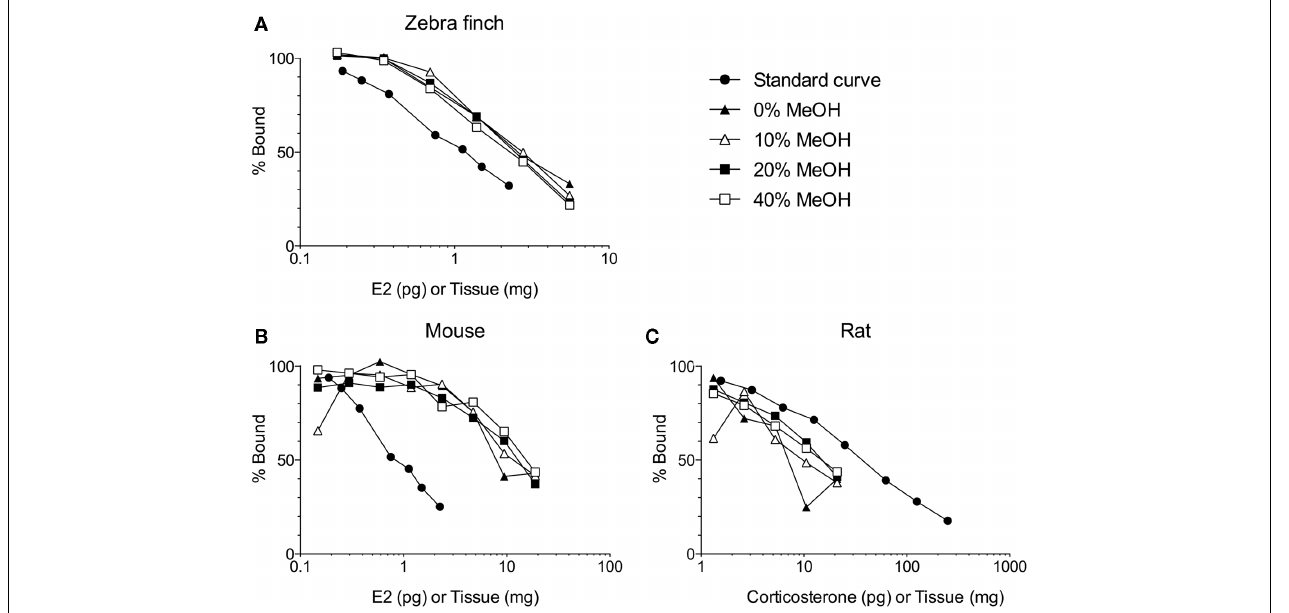
samples were mixed and then left overnight at 4˚C.The samples were mixed again and centrifuged (3000g, 10min, 2˚C). Supernatants ( ≤ 1ml) were diluted with 10ml deionized water and loaded onto C 18 columns (500mg C 18 , non-endcapped). Prior to sample loading, the C 18 columns were primed with 3ml ethanol and equilibrated with 10ml deionized water. After sample loading, columns were washed with 0, 10, 20, or 40% MeOH (10ml) and steroids were eluted with 5ml 90% MeOH. Eluates were dried in a vacuum centrifuge and resuspended in assay buffer. All reagents were HPLC-grade. E 2